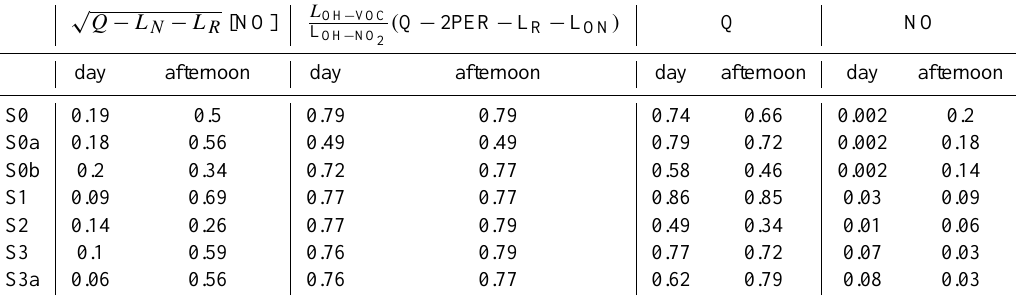
Table 2. R 2 values beteewn P(O 3 ) and 18:00) and afteroon